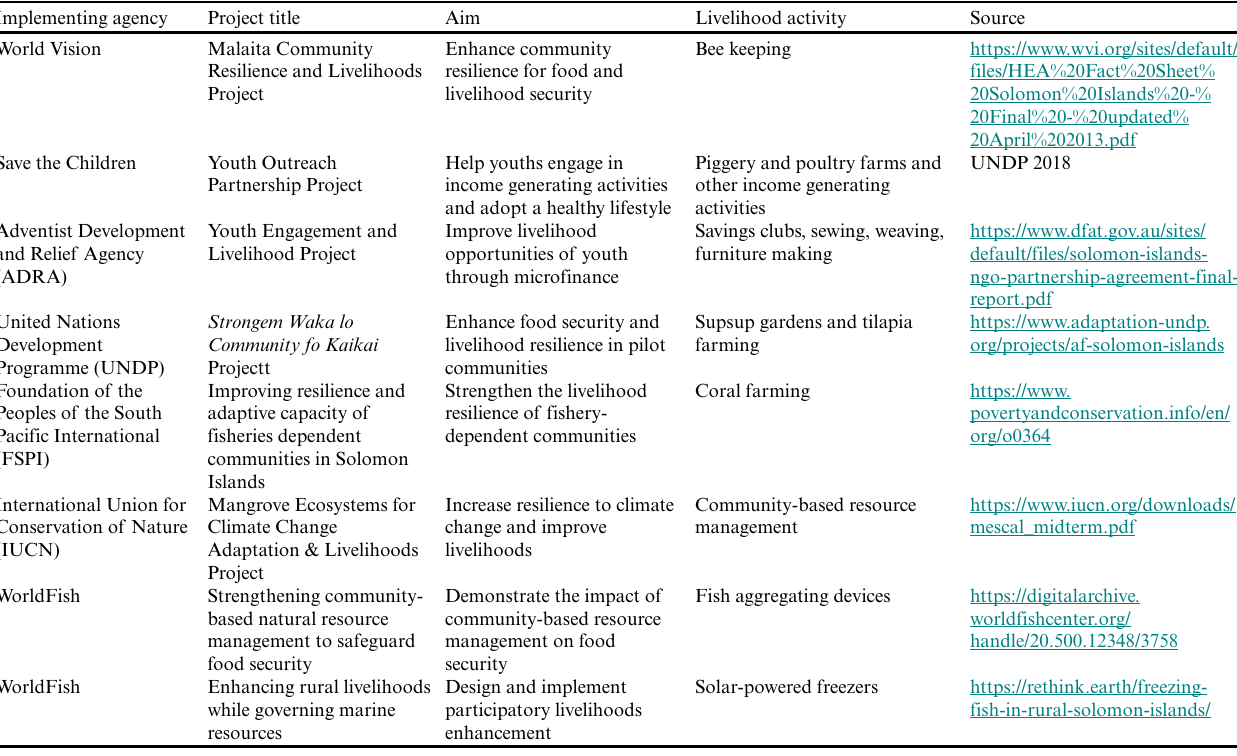
Table 3 . Examples of rural development projects, which explicitly aim to diversify livelihoods and improve food security in Malaita Province, Solomon